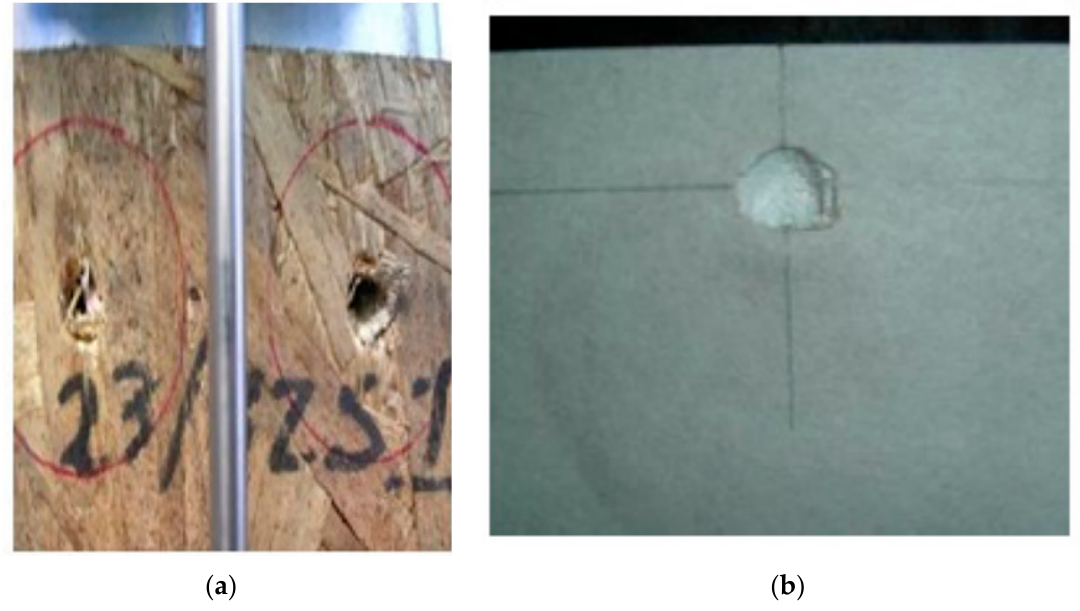
Figure 11. ( a ) Pull through failure of a wood sheathing connection to frame [44]; ( b ) bearing failure of a gypsum sheathing connection to frame.